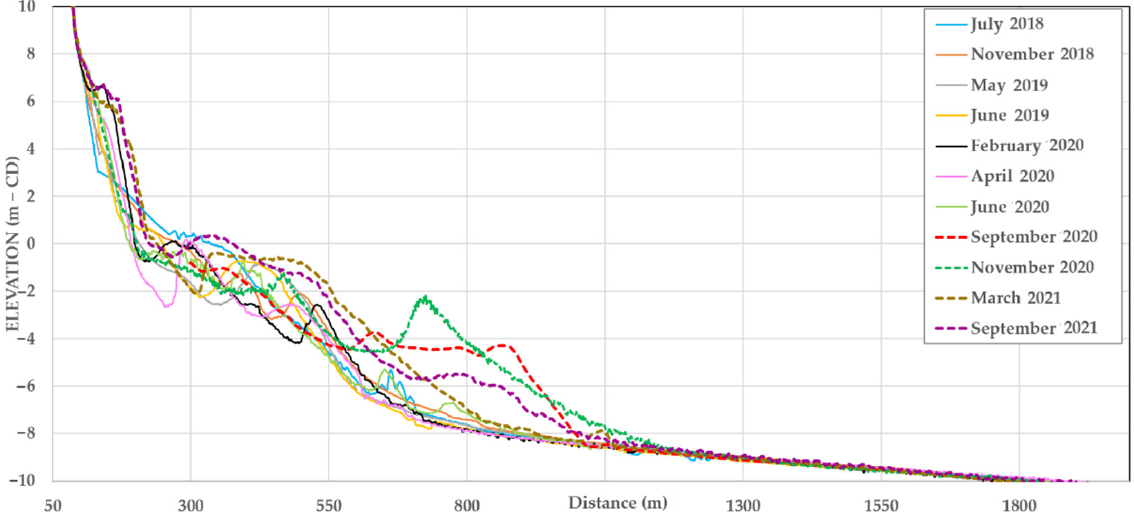
Figure 7. Beach Shoreface Profiles (BSP) at Costa Nova between July 2018 and September 2021. The red dotted line of September 2020 represents the final construction profile of the shoreface nourishment (elevations referred to CD—Chart Datum).